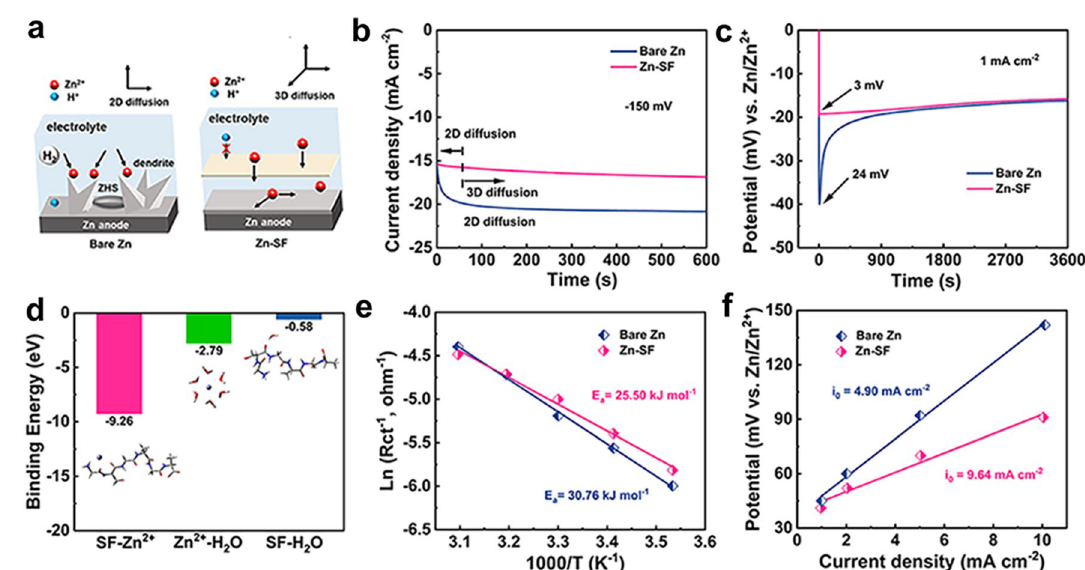
Fig. 4 Investigation of SF‑assisted deposition and desolvation behavior. a Schematic diagram demonstrating the SF‑assisted uniform deposition and suppressed H 2 . b Chronoamperometry curves at an overpotential of ‑150 mV. c Nucleation overpotentials of Zn electrodeposition. d Binding energy between Zn 2+ and various molecules (H 2 O and GSGAGA) from density functional theory calculations. e Desolvation activation energies fitted by Arrhenius curves. f Exchange current densities from Tafel curves at 1 mV s.